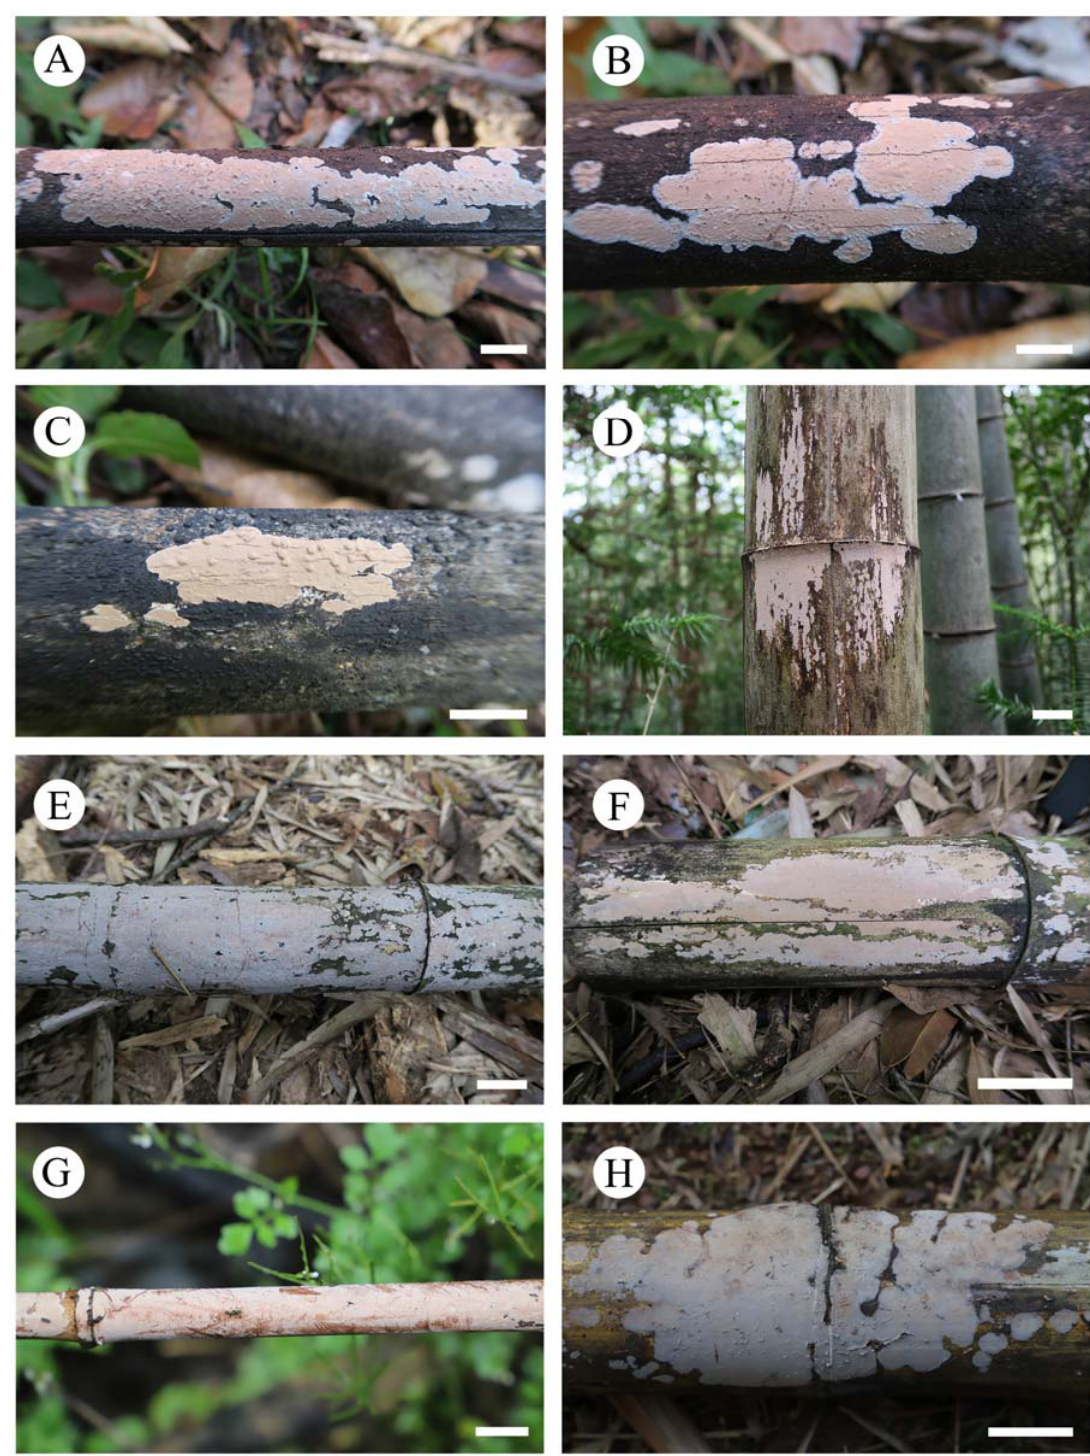
Figure 6. Basidiomes of Heterocorticium bambusicola . Scale bars: ( A–H ) = 1 cm. ( A ). He 3341 (BJFC 021736); ( B ). He 3344 (BJFC 021739); ( C ). He 3359 (BJFC 021754); ( D ). He 4234 (BJFC023676); ( E ). He 4604 (BJFC 024046); ( F ). He 4607 (BJFC 024049); ( G ). He 6293 (BJFC 033237); ( H ). He 6435 (BJFC 033379).